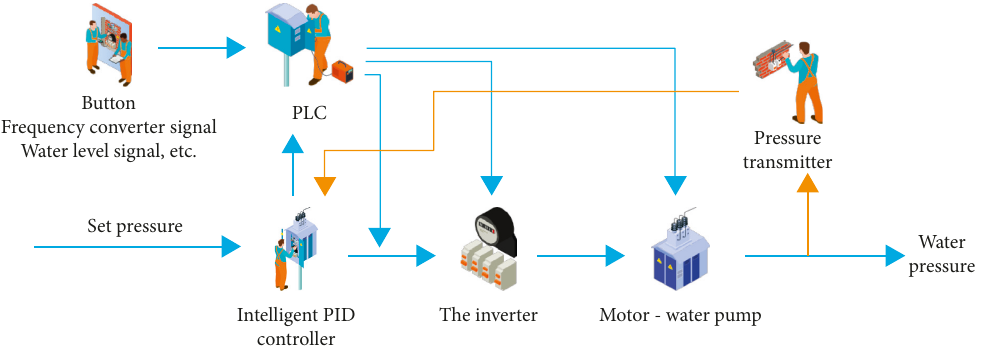
Figure 1: Application of a frequency converter in electric automatic control of central